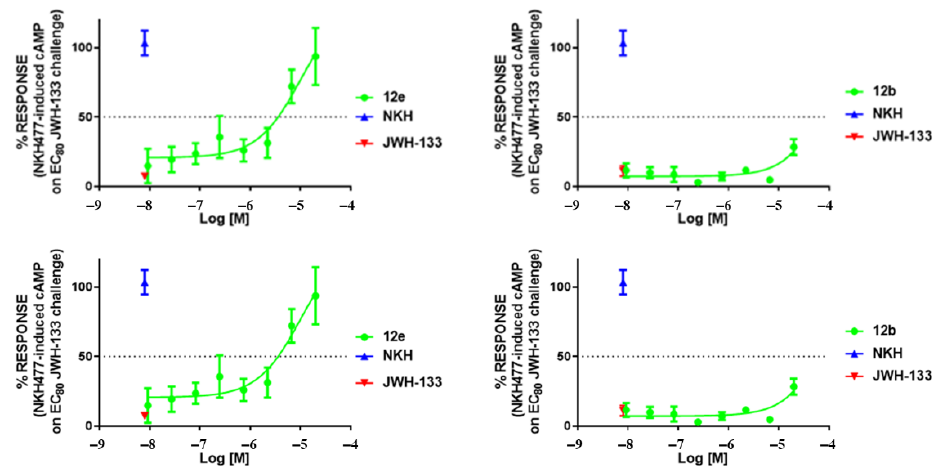
Figure 8. Concentration − response curves of compounds in the cAMP Hunter assay. Curves show the effect of increasing concentrations of compounds on NKH-477-induced cAMP levels in stable CHO cells expressing the human CB2 in the presence of an agonist challenge (JWH-133, 4 µ M). Data are reported as the means ± SEM of three independent experiments conducted in triplicate, normalized to the maximal and minimal responses.